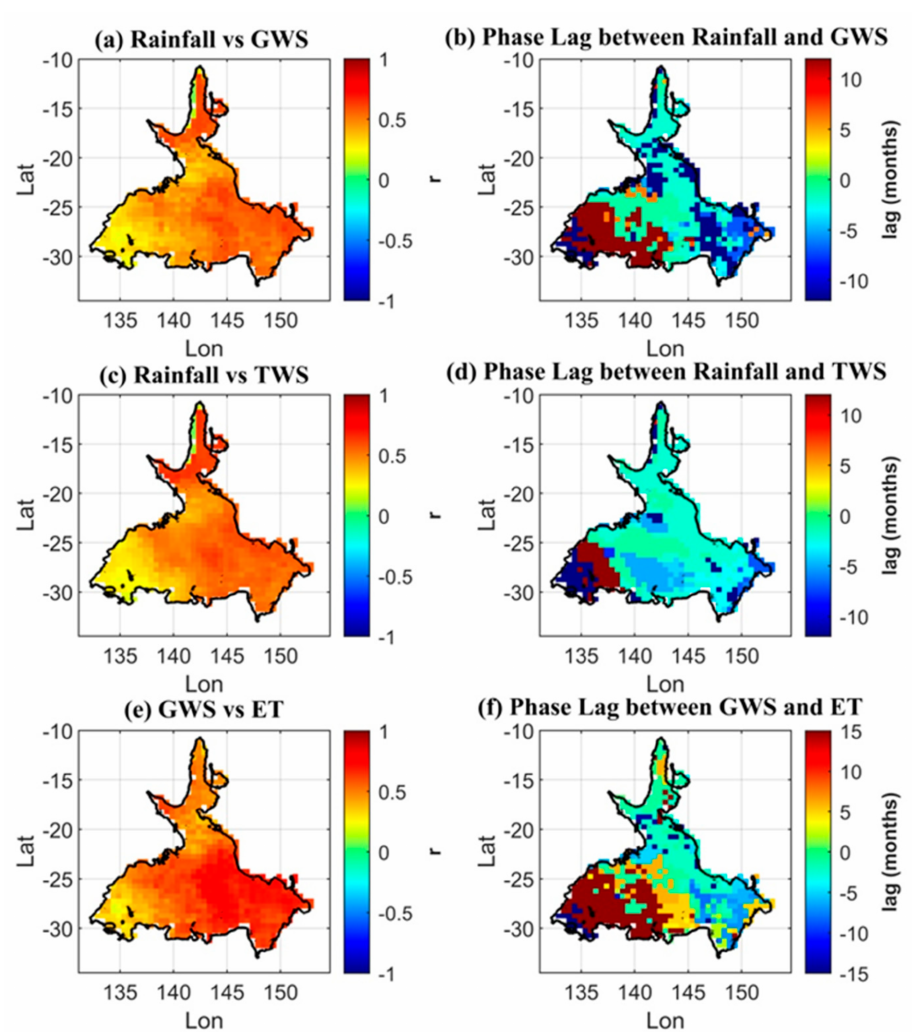
Figure 9. Cross-correlation analysis depicting spatial variation in correlation coefficients ( r ) and phase lags in months at which maximum correlations occur for ( a , b ) Rainfall vs GWS, ( c , d ) Rainfall vs TWS, and ( e , f ) GWS vs ET. Positive values of lag months indicate that rainfall lags GWS variation and negative values depict rainfall precedes GWS variation. The value of r represents correlation coefficients in the